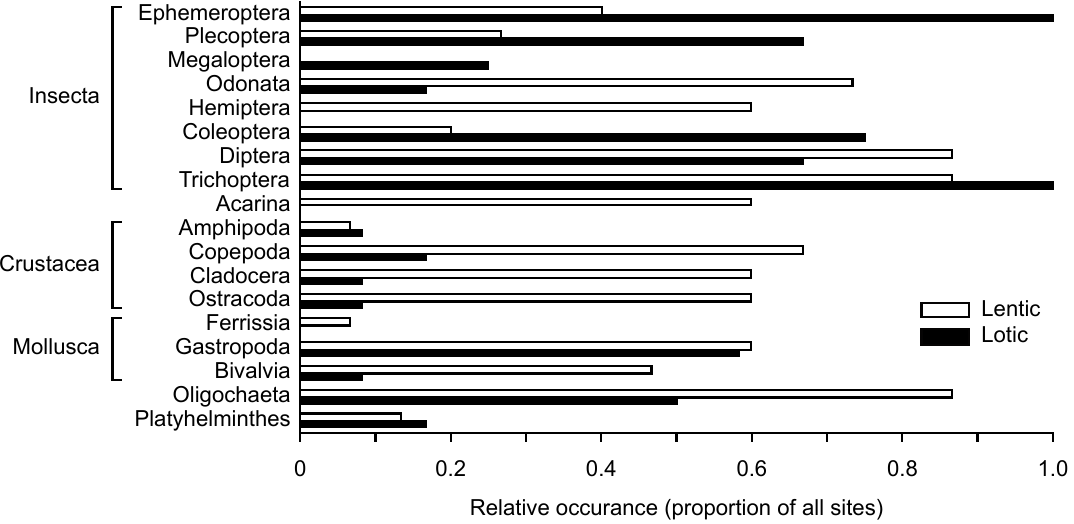
Figure 3. Composition of aquatic invertebrate fauna in lentic and lotic Galaxias habitats. Bars indicate the proportion of habitats sampled in which a particular taxonomic grouping occurred. Taxonomic groups follow those of Stark et al. [58] .